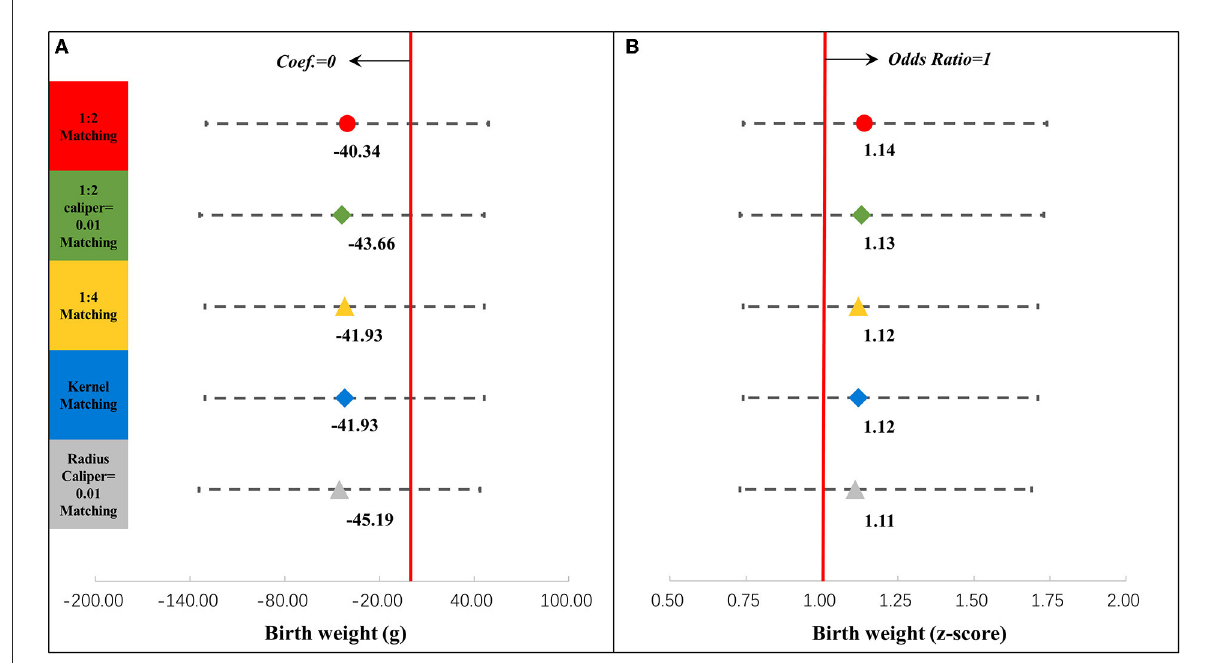
FIGURE5 Results of regression analysis of the birth weight (A) and birth weight z-score (B) after propensity score matching. * P < 0.05, ** P < 0.01, *** P < 0.001. The results of different propensity score matching analyses are reported too. Dots and lines represent means and 95% confidence intervals for Coef. or ORs estimated from generalized linear mixed regression analyses. Maternal, family, and infant characteristics were also included in the regression analyses but are not reported. Details are shown in Supplementary Table 5. Coef, coefficient; OR, odds